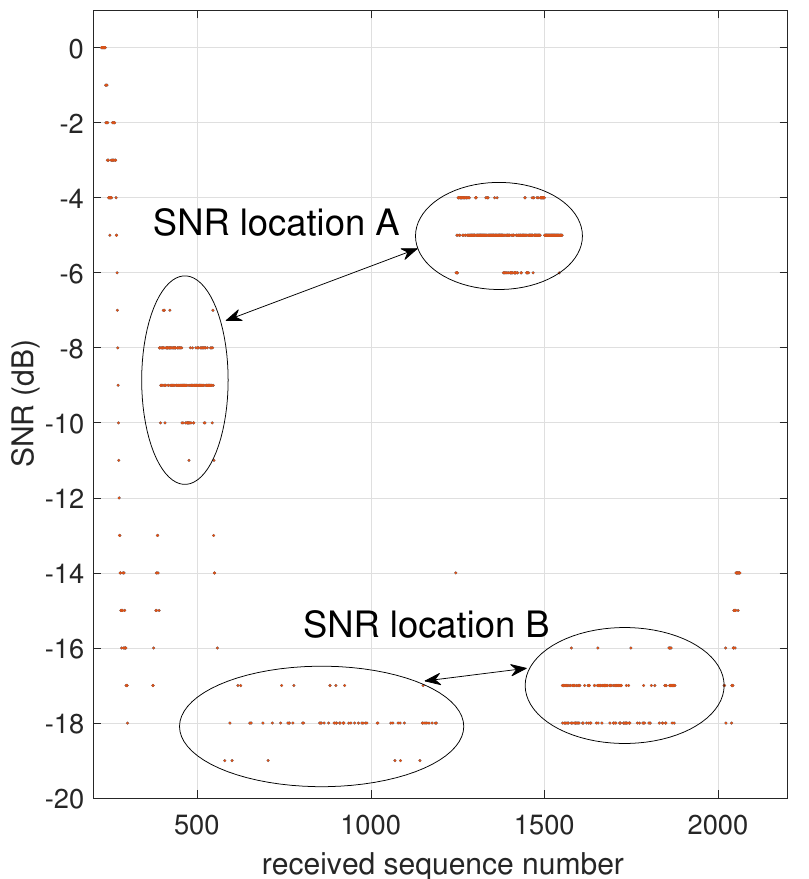
Figure 11. SNR measured at two positions separated by 500